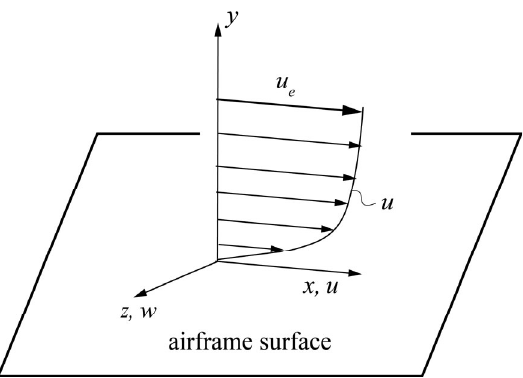
Figure 4. The local coordinate system of the airframe boundary layer.